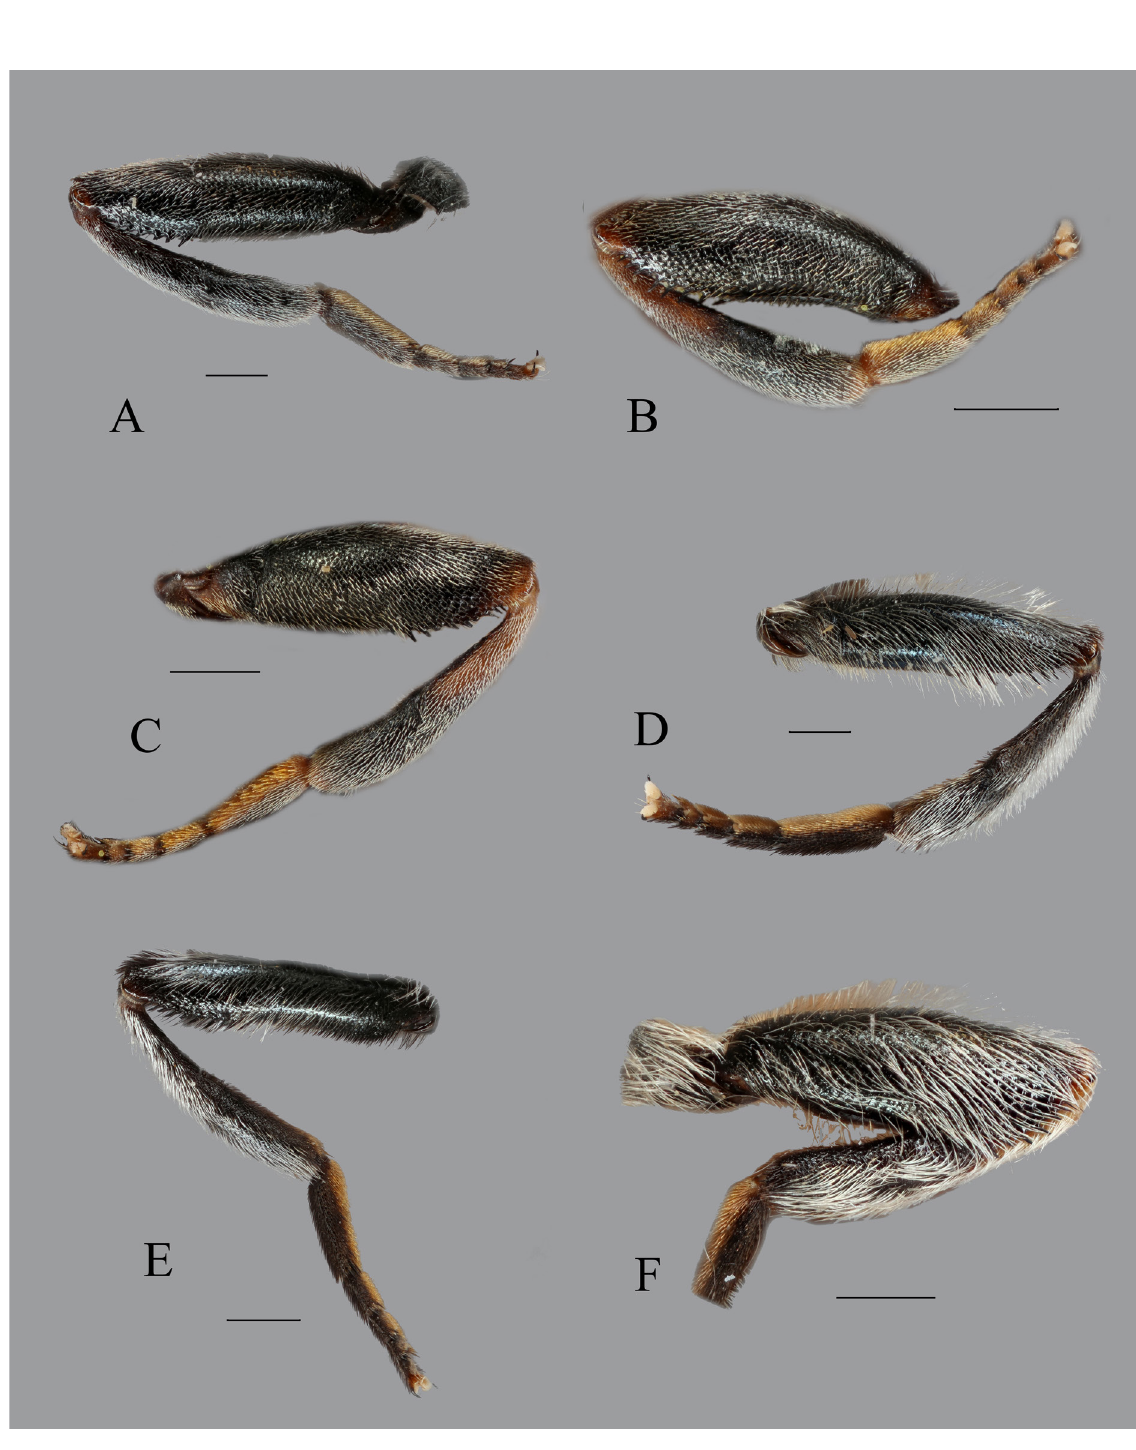
Fig. 9. Metaleg, lateral view. A . Eumerus atricolorus Gilasian & van Steenis sp. nov., holotype, ♂ (HMIM). B . E. brevipilosus Gilasian & van Steenis sp. nov., holotype, ♂ (HMIM). C . E. brevipilosus Gilasian & van Steenis sp. nov., paratype, ♀ (HMIM). D . E. chekabicus Gilasian & van Steenis sp. nov., holotype, ♂ (HMIM). E . E. hissaricus Stackelberg, 1949 , ♂, Ghoochan, Iran (HMIM). F . E. ovoformus Gilasian & van Steenis sp. nov., holotype, ♂ (HMIM). Scale bars = 0.5